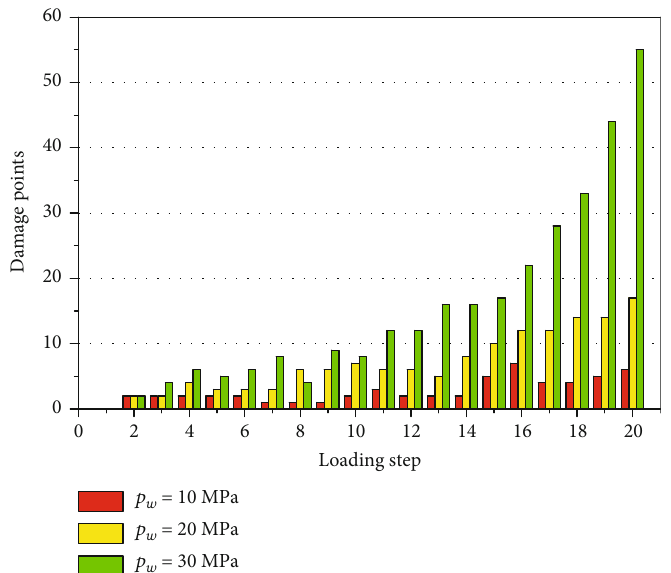
Figure 5: The number of damage points changes with the loading step.